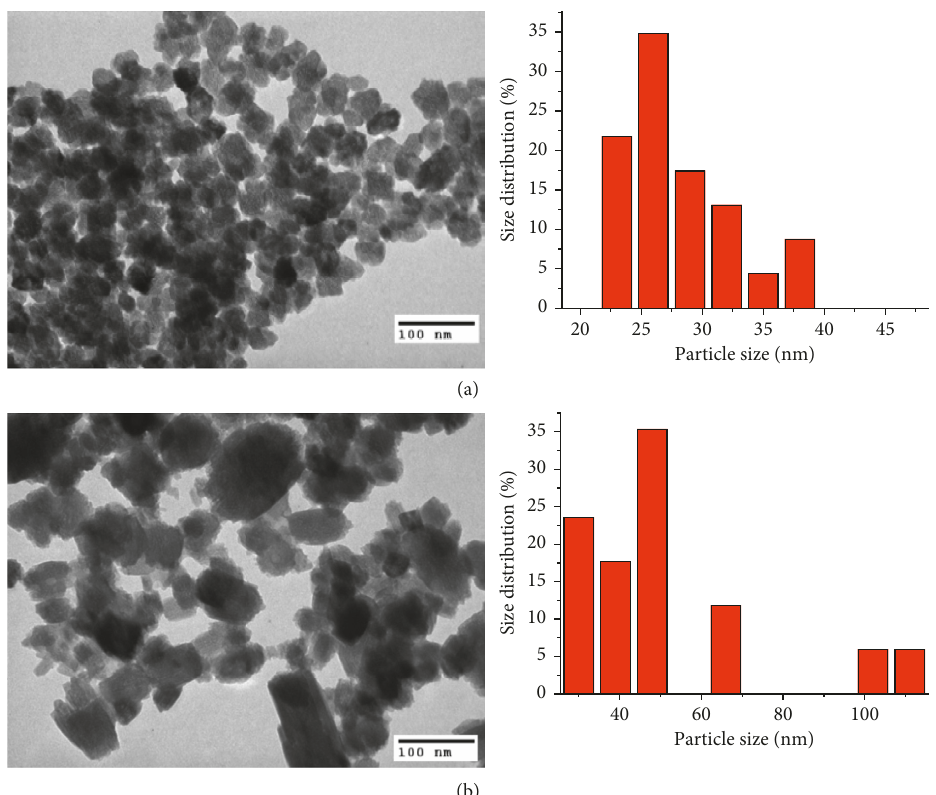
3+ nanoparticles synthesized by sonochemical (a) and thermal 4 :Eu